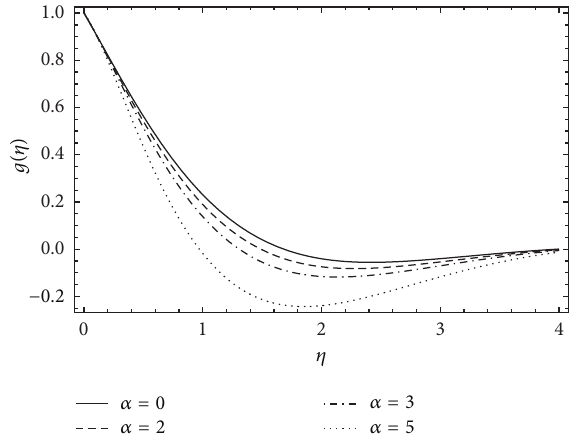
Figure 6: The influence of the rotation parameter 𝛼 on 𝑔(𝜂) for 𝜆 = 1 , ℏ = −0.2 .